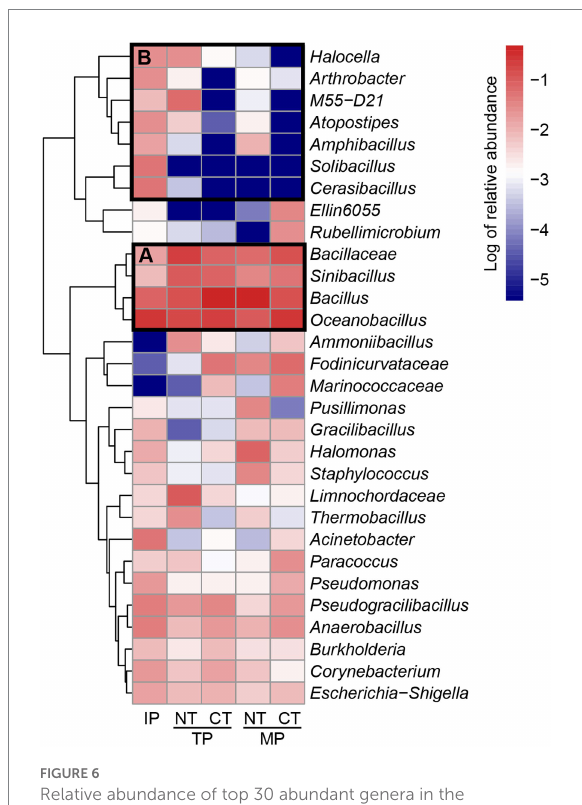
FIGURE 6 Relative abundance of top 30 abundant genera in the transconjugant pools during normal thermophilic (NT) and continuous thermophilic composting (CT). IP, TP, and MP represent the initial, thermophilic, and mature phases, respectively. (A) dominant conjungants in all samples; (B) removal of RP4 plasmid